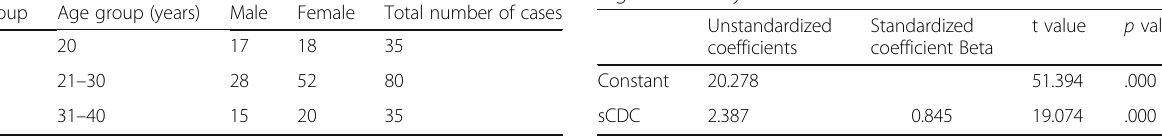
Table 2 Showing relation between age and CDC using regression